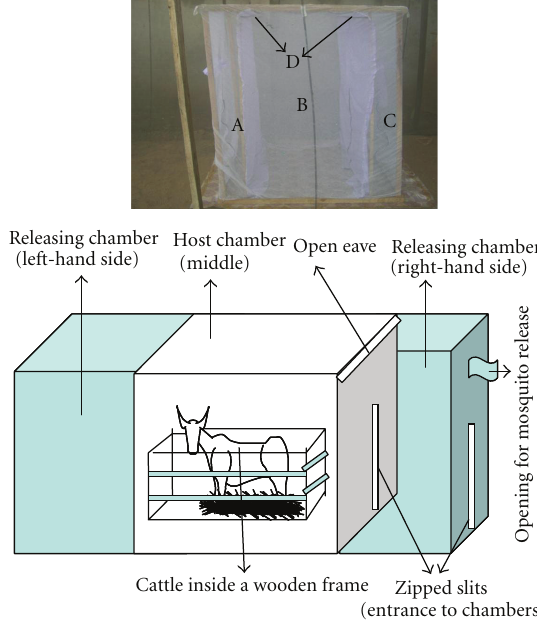
Figure 1: Picture of a rectangular net hut and its schematic representation. The sections of net hut are (A) left-hand side releasing chamber, (B) host or middle chamber, (C) right-hand side releasing chamber, and (D) open eaves with ba ffl es to allow host- seeking mosquitoes to enter host chamber.